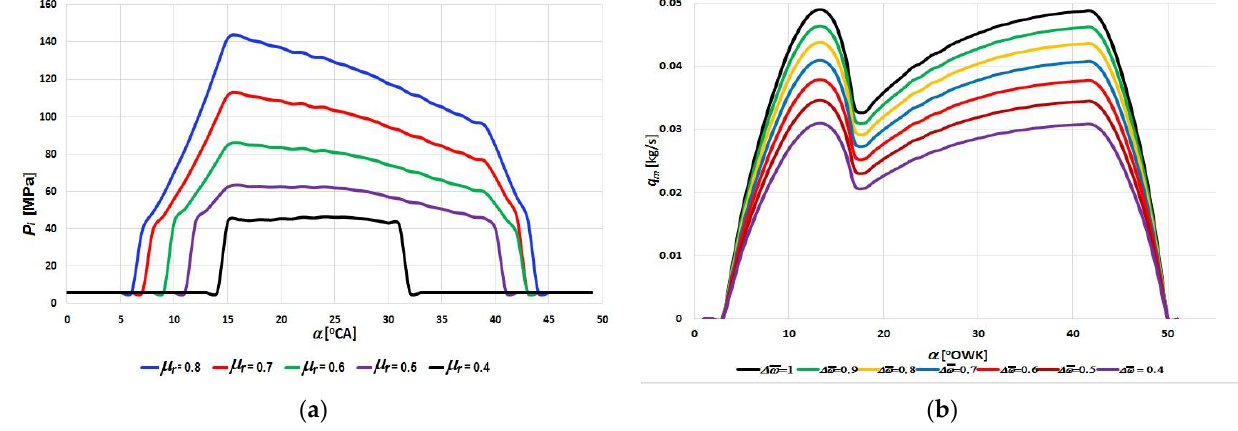
Figure 4. Influence of the value of the flow coefficient μ r on the pressure course in the injector nozzle space p i ( a ) and influence of the relative pressure losses Δ 𝜔̄ through the spray holes on the fuel mass flow q m ( b ).